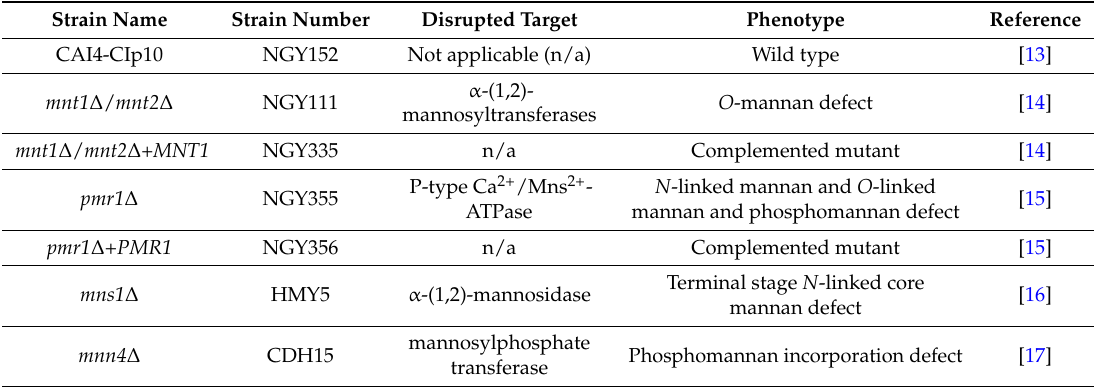
Table 1. Strains of C. albicans used in this